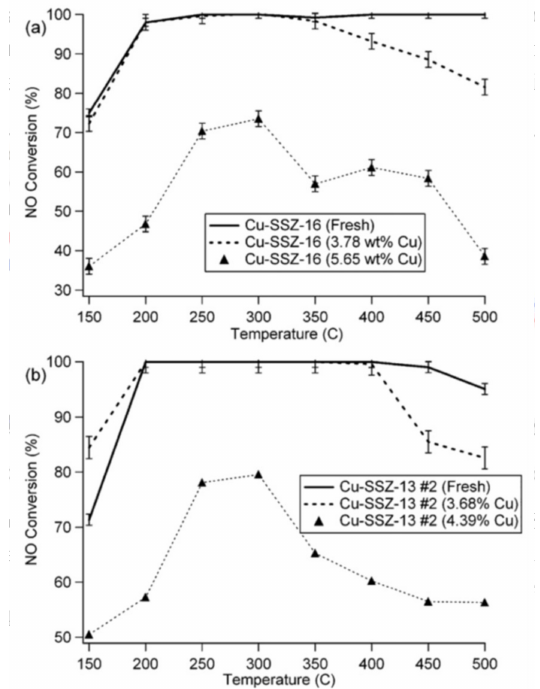
Figure 15. Comparing the effect of copper loading on the NH 3 -SCR activity and hydrothermal stability for ( a ) Cu-SSZ-16 and ( b ) Cu-SSZ-13. Reprinted from Appl. Catal. B-Environ. , 2011 , 102 , 441–448. Copyright 2011, with permission from